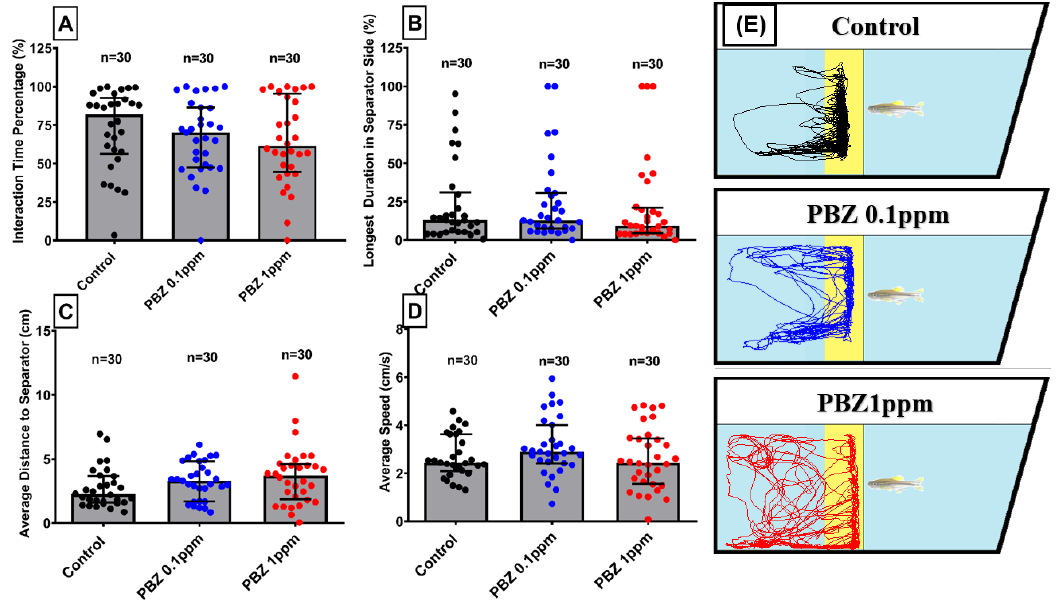
Figure 8. Social interaction test for adult zebrafish after exposed to different doses of Paclobutrazol. Four endpoints were measured including: ( A ) interaction time percentage, ( B ) duration of stay in separator side, ( C ) average distance to the separator, and ( D ) average Speed. ( E ) Trajectories of adult zebrafish in social interaction assay after exposed to 0 (control), 100 µg/L (0. 1 ppm), and 1000 µg/L (1 ppm) of Paclobutrazol (PBZ). The data are expressed as the means ± S.E.M. and were analyzed by the one-way ANOVA.